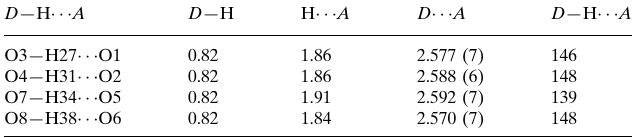
Hydrogen-bond geometry (A˚ , (cid:3)